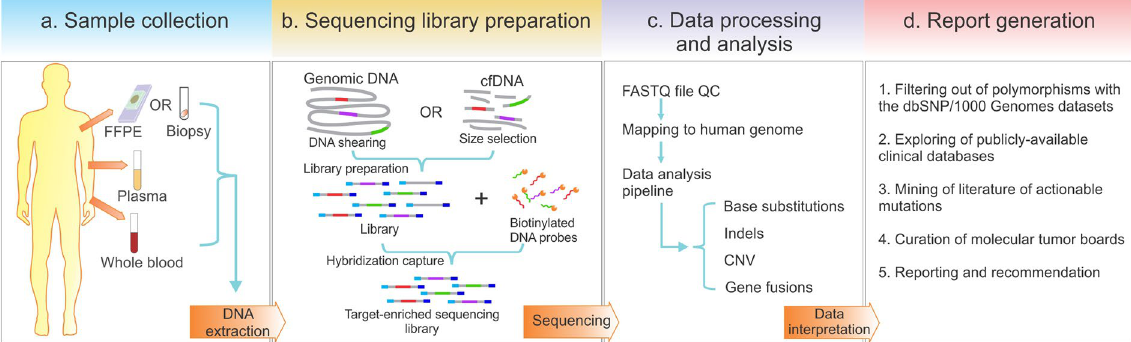
Figure 2. Workflow of targeted NGS-based mutation profiling. ( a ) Genomic DNA is extracted from multiple sample types. ( b ) Whole-genome libraries are prepared from fragmented genomic DNA or cfDNA, followed by hybridization capture with biotinylated DNA probes to establish target-enriched sequencing libraries for NGS. ( c ) Sequencing data undergoes quality control (QC), mapping and bioinformatic analysis to identify different classes of genomic aberrations. ( d ) Mutations identified are filtered and annotated according to related databases, and their clinical significances are interpreted in the final